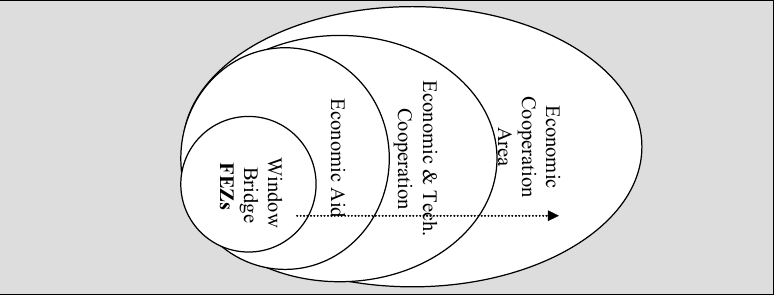
Transformation of Regional-Oriented Preferential